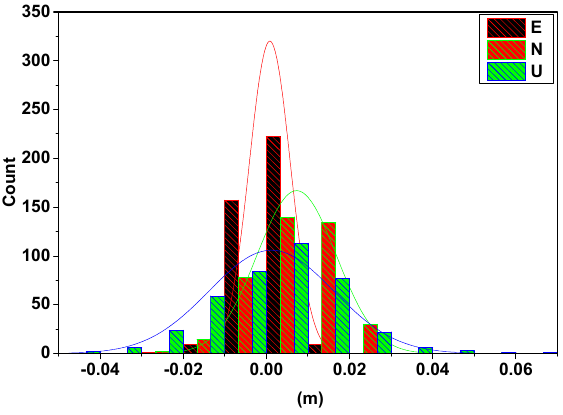
Figure 12. The counts of the difference between the ARTK and the SRTK techniques.